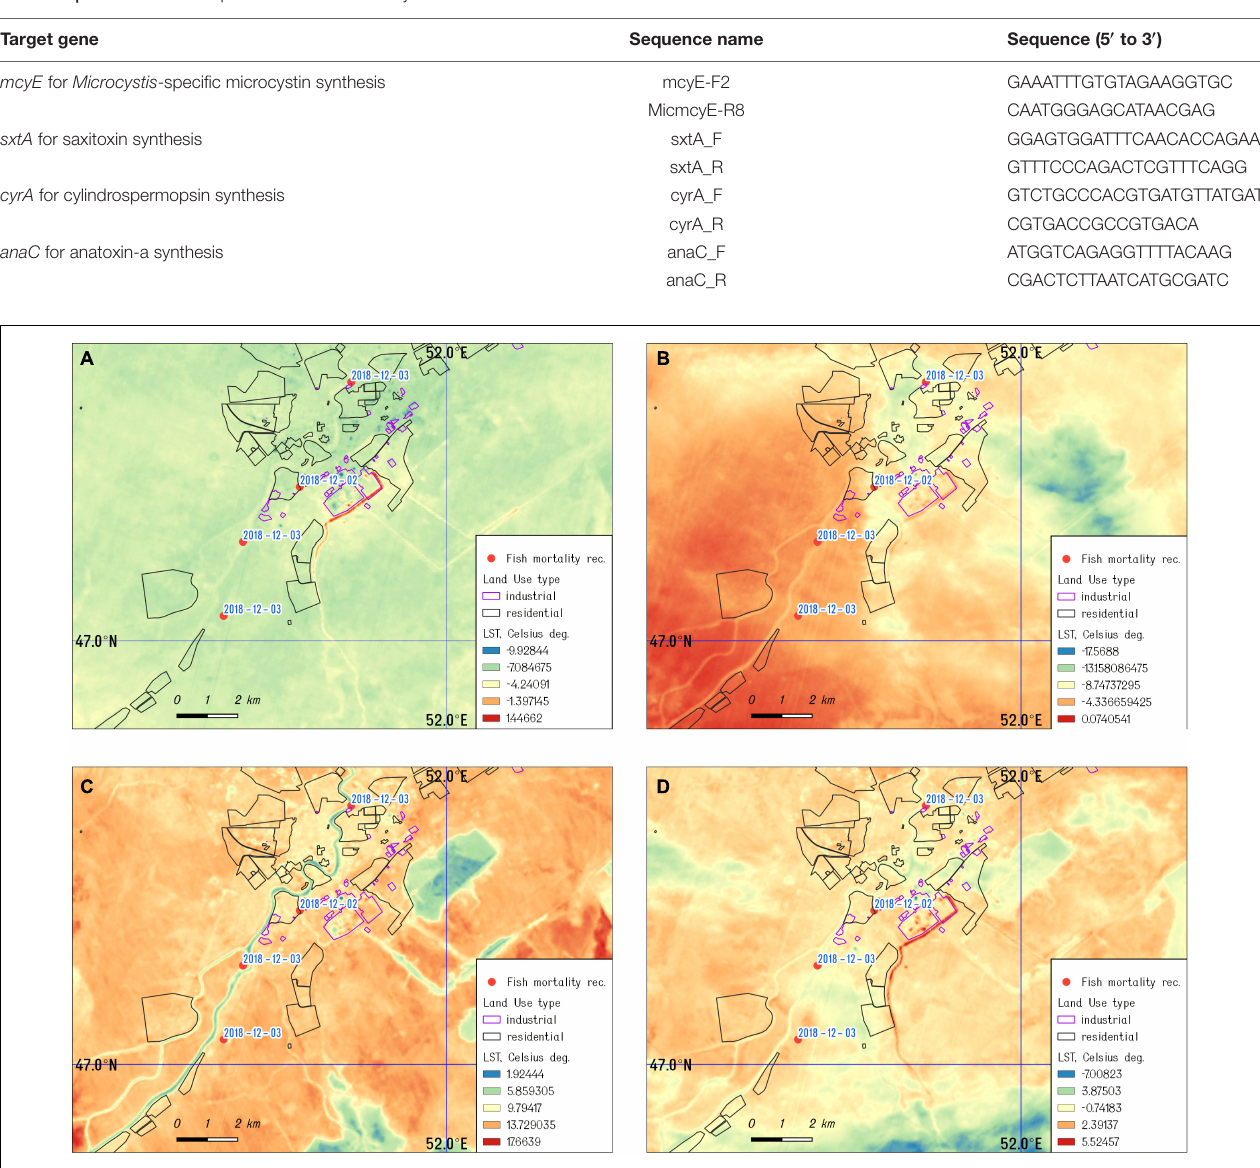
TABLE 1 | List of consensus primers used in the study.